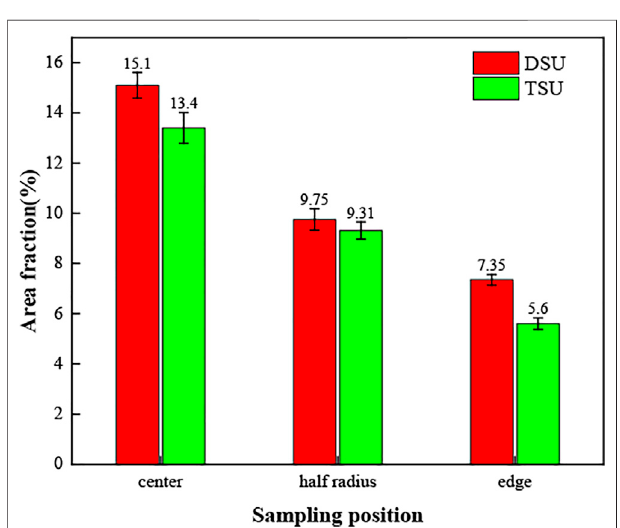
FIGURE 9 | Area fraction of the Al 2 Cu